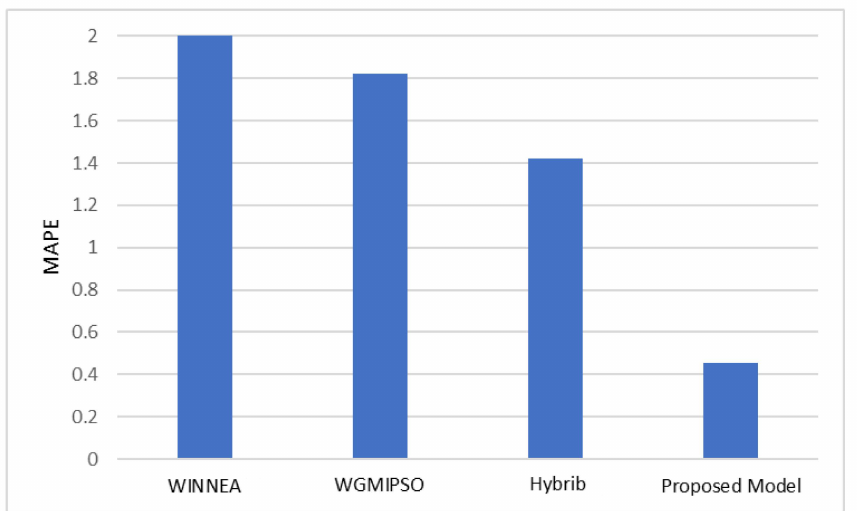
Figure 11. Comparison of proposed model with other hybrid models in terms of MAPE. WTN- NEA [32], WGMIPSO [33] and an other hybrid model